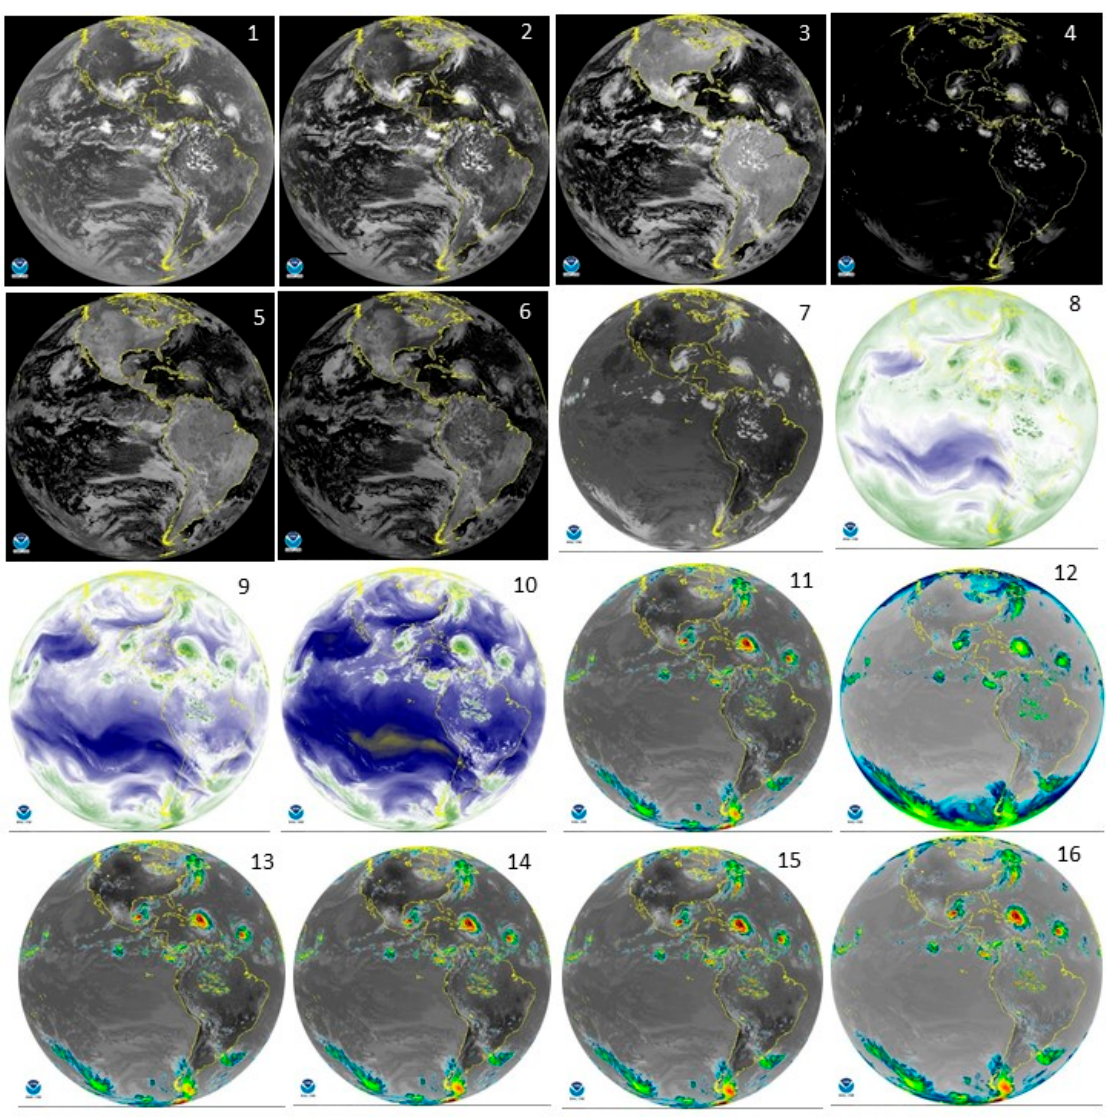
Figure 17. ABI full disk images of all 16 bands collected on 7 September 2017 at 1830 UTC. The band numbers are indicated on the top right of each image.